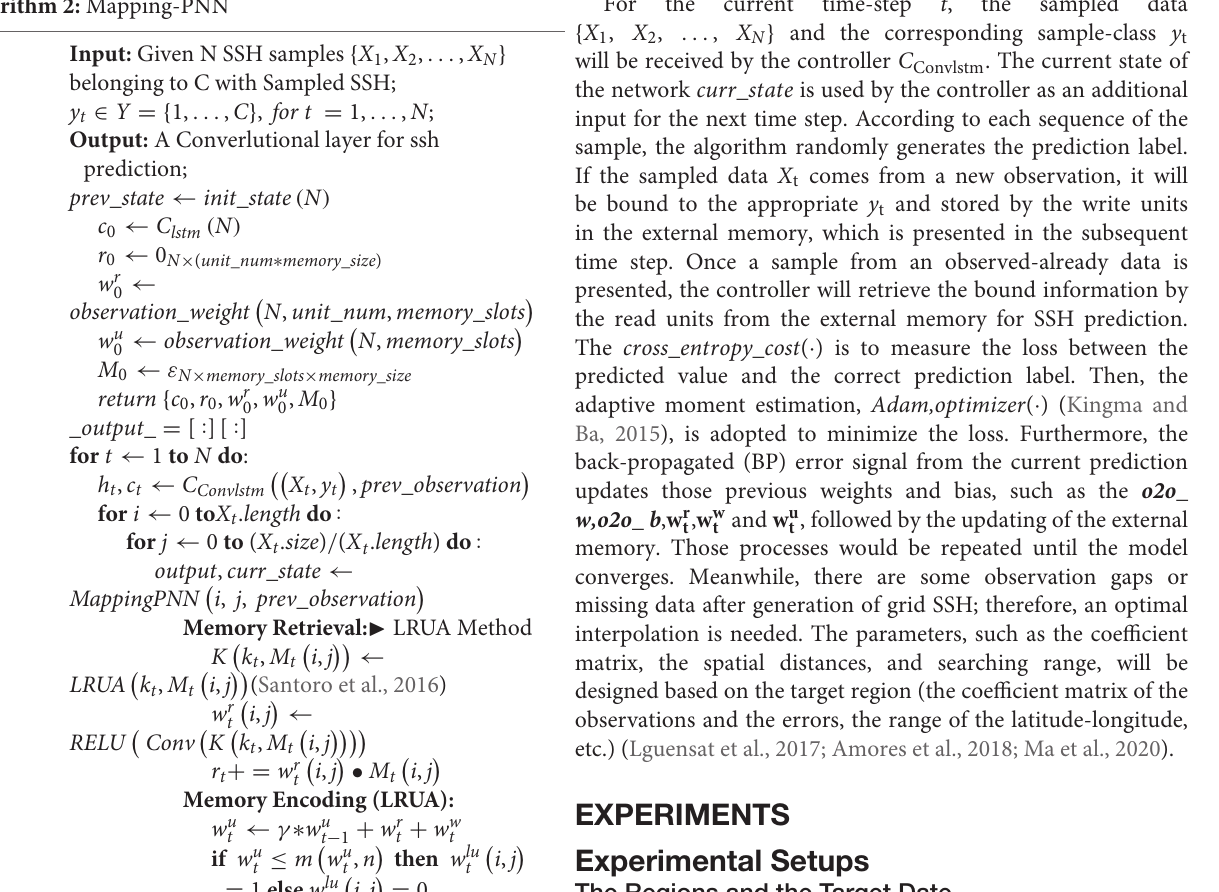
Algorithm 2 was proposed, as shown: Algorithm 2 , the improvement details of the Mapping-PNN, adopted the LRUA method. Algorithm 2: